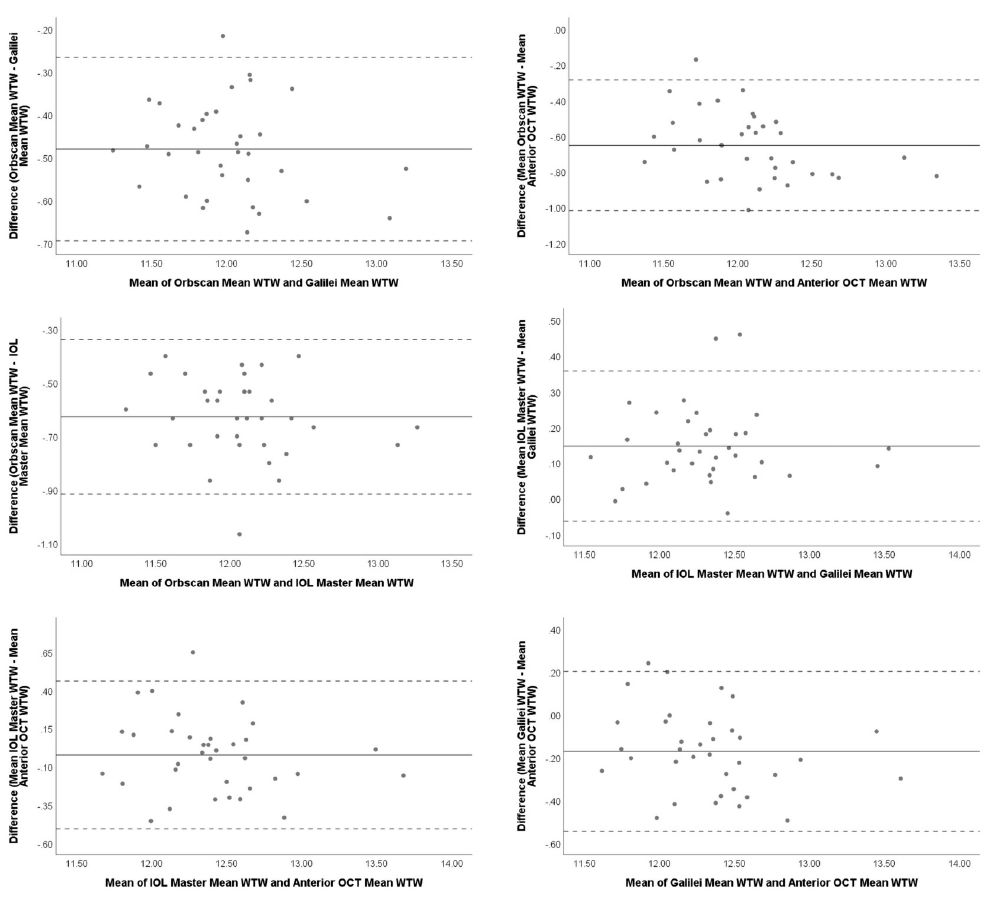
Fig 1. Bland-Altman plots for horizontal visible iris diameter (HVID)/white-to-white(WTW) measurements between device pairs (mm). Solid lines show the mean of the difference between the 2 devices while dotted lines represent 95% limits of